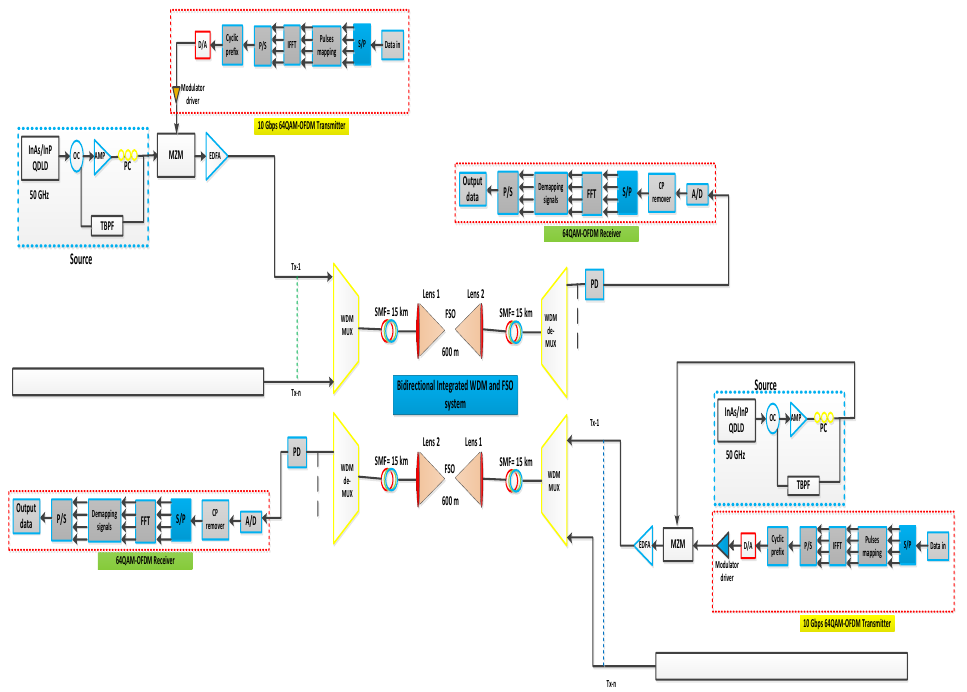
Figure 1. Bidirectional hybrid WDM-FSO link presented